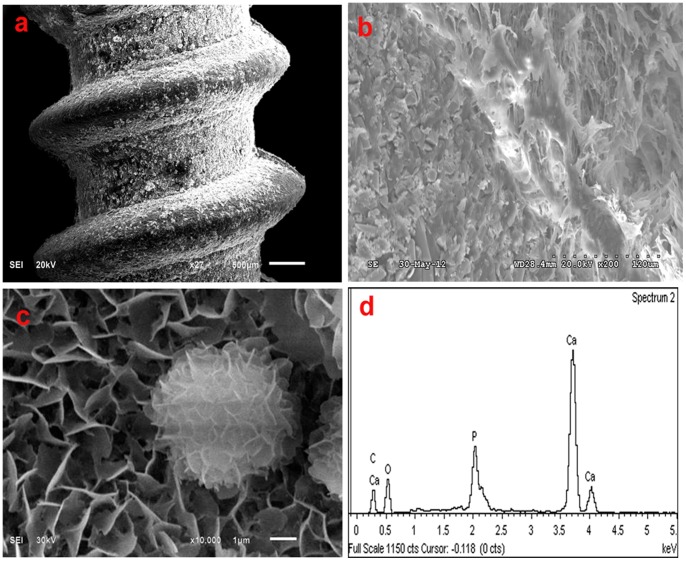
SEM and EDS micrographs of the n-HA/PA66/GF screw.(a) Coating layer. (b) Cross section. (c) n-HA particles on the screw surface. (d) EDS graph of the coating layer.